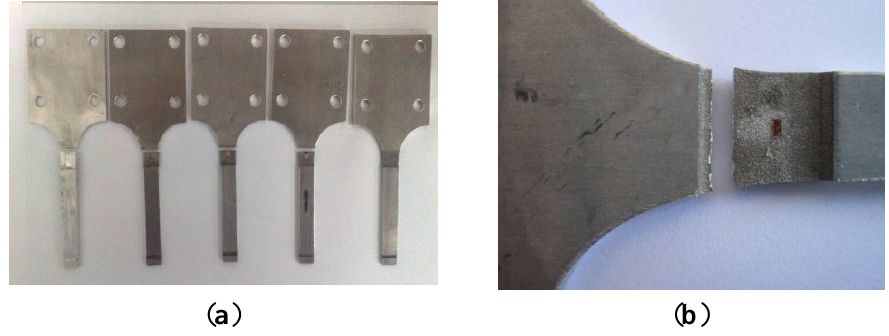
Figure 13. Photos of the damaged specimen. ( a ) Damaged specimen; and ( b ) Fracture morphology.